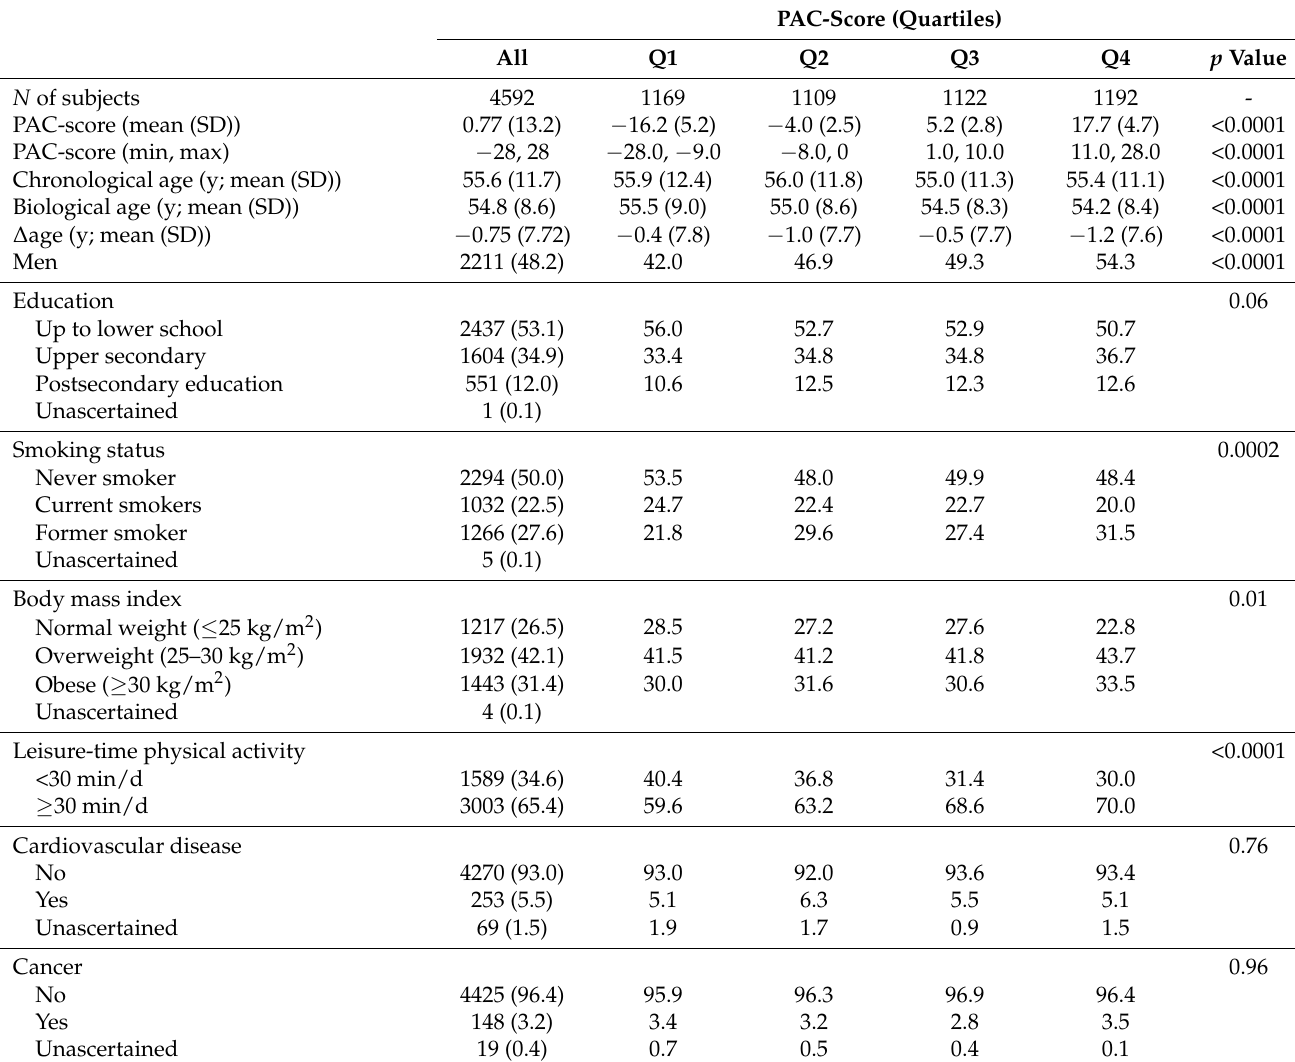
Table 1. Main characteristics of the study population ( n = 4952) by quartiles of